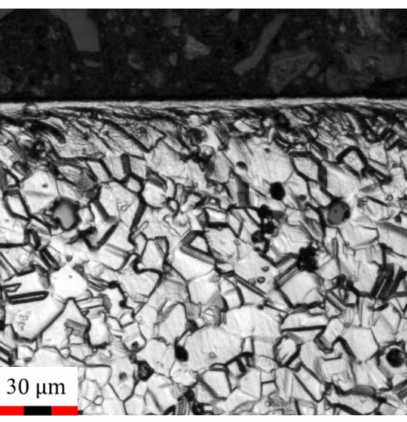
Figure 1. Microstructure of the specimens before compression. The single-pass compression was performed in Forging Machine DP-C41L13 at a forging temperature of 1020 ◦ C, loading speed of 25 mm/s, and press amount of 16 mm. The depth of the compressed specimen was 20 mm and it was water-cooled immediately. The specimen shapes before and after forging are shown in Figure 2.